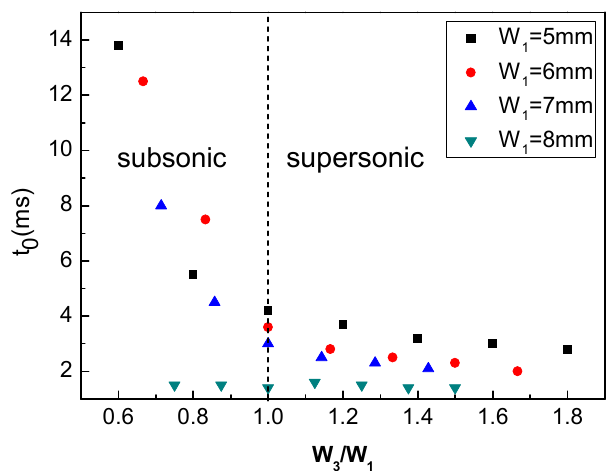
Figure 10. Delay time of oscillators with different structures.